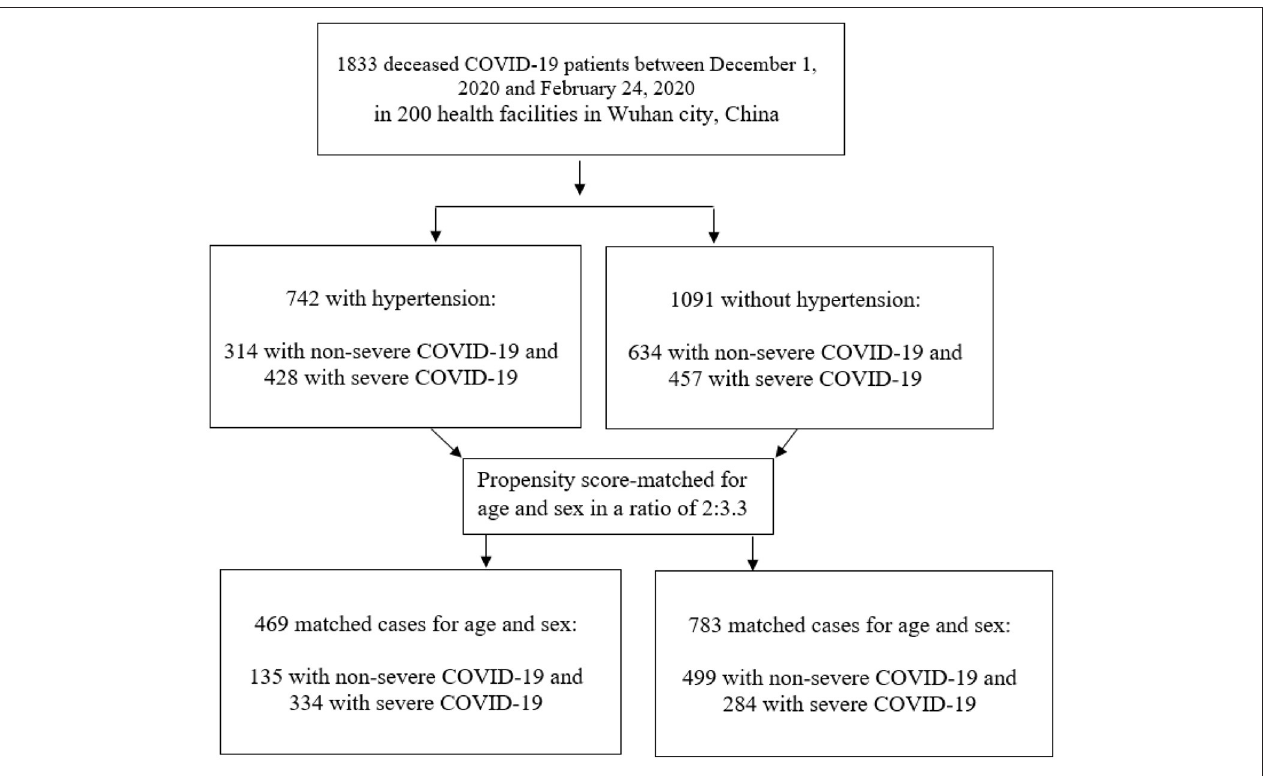
FIGURE 1 | Study flow